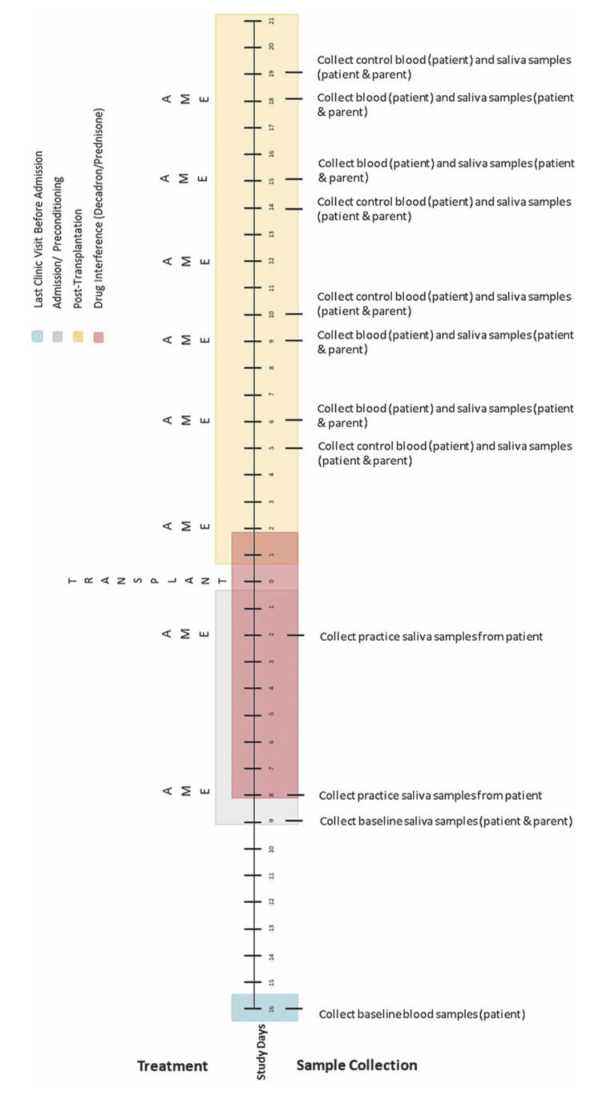
FIGURE 3 | Collection schedule for children undergoing allogenic transplant. Reprinted from Russ et al.